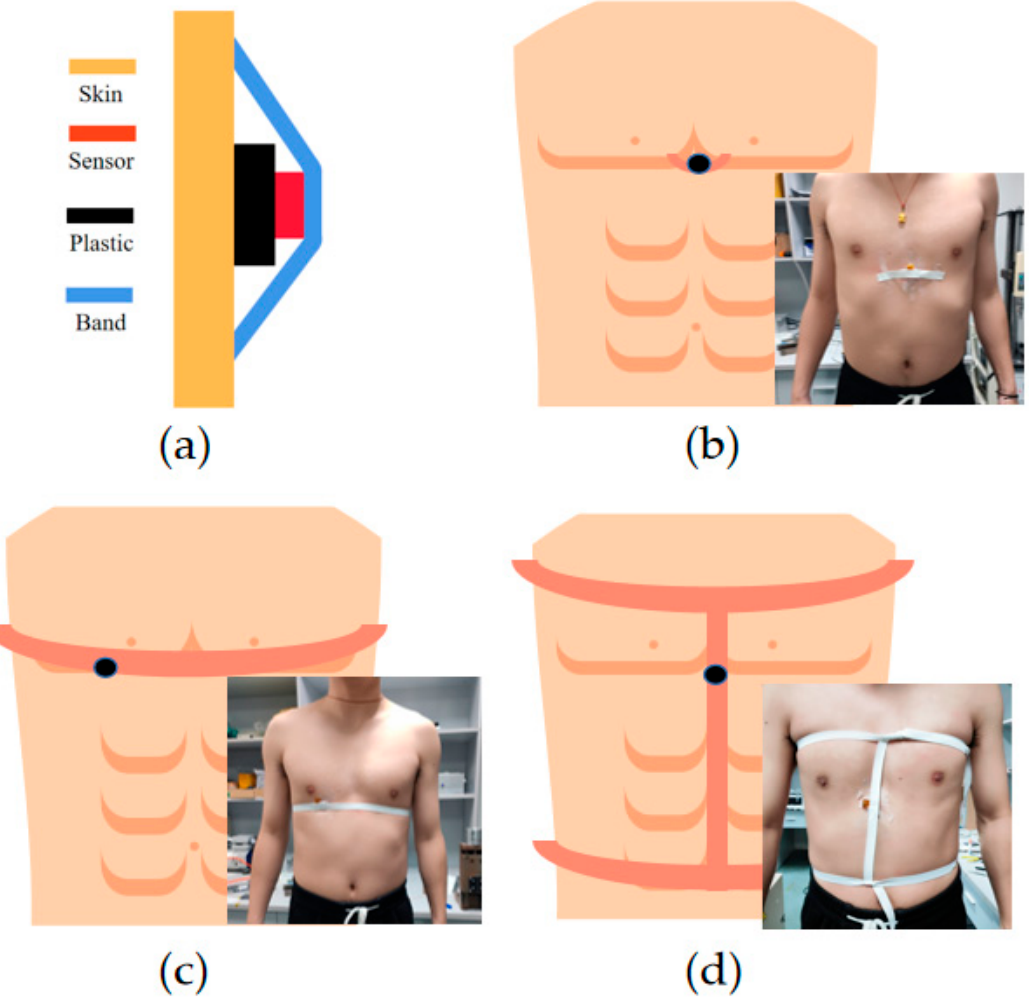
Figure 6. ( a ) Fixation structure of the pressure sensor for vital signal monitoring; ( b ) device fixation method for heartbeat monitoring; ( c ) device fixation method for breathing monitoring; ( c ) device fixation method for simultaneous monitoring of heart rate and respiratory rate.